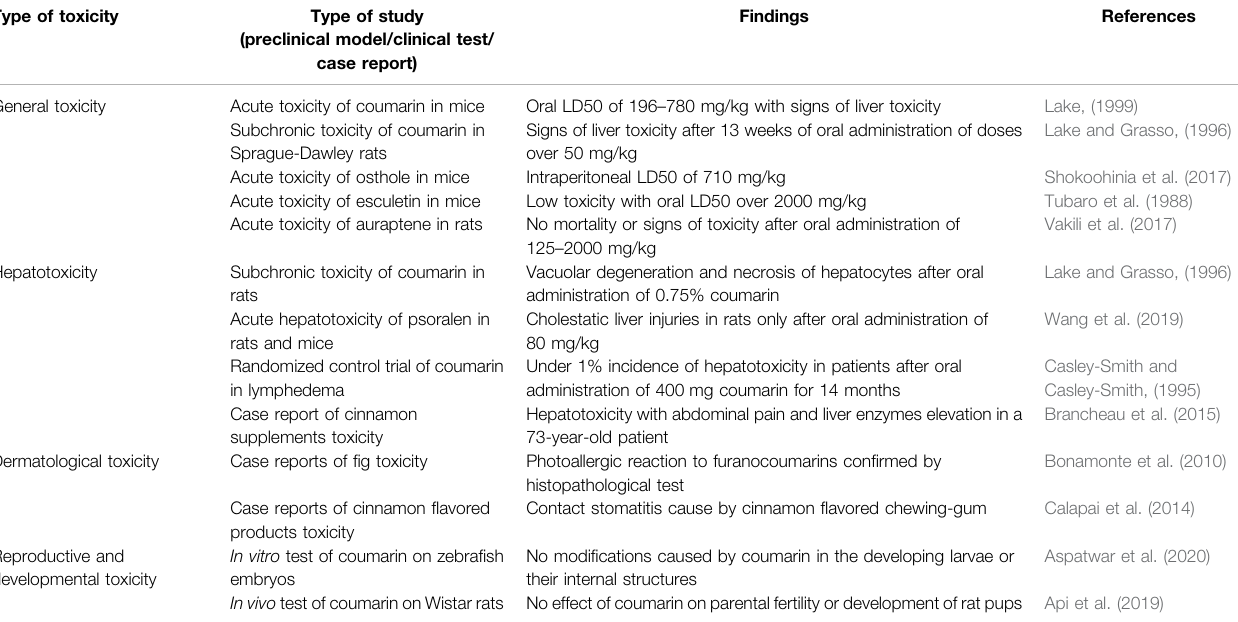
TABLE 2 | Toxicological aspects concerning natural